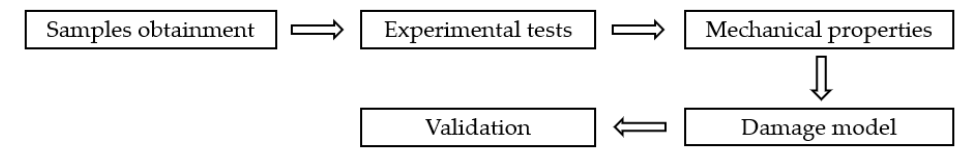
Figure 1. Outline of the investigation.